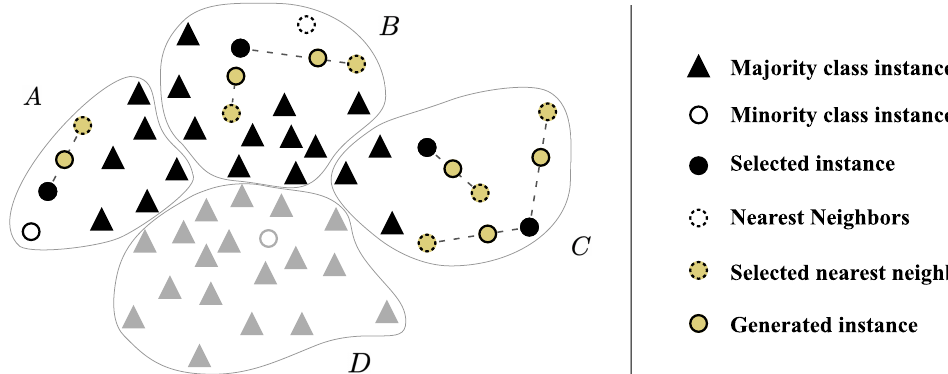
Figure 3. Example of K-means SMOTE’s data generation process. Clusters A , B and C are selected for oversampling, whereas cluster D was rejected due to its high imbalance ratio. The oversampling is done using the SMOTE algorithm and the k nearest neighbors selection only considers instances within the same